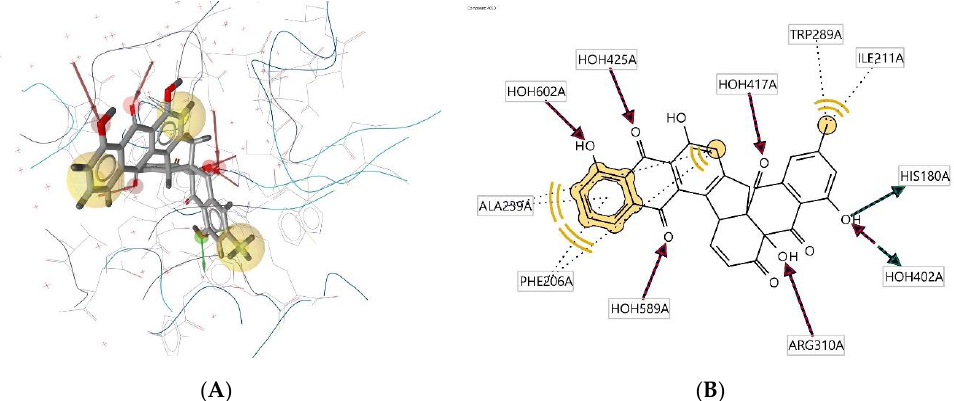
Figure 6. Ligand 465D interacts with the macromolecule. ( A ) 3D view of pharmacophore at macro- molecule binding site. ( B ) 2D view of the pharmacophore. Pharmacophore features: hydrophobic interactions (H), yellow; hydrogen bond acceptor (HBA), red; hydrogen bond donor (HBD), green. Ligand 302D interacts with the macromolecule, as shown in Figure 7A,B. It shows hydrophobic interactions with amino acids Thr266A, Trp82A, Thr134A, Phe206A, Trp289A, and Ile211A. This pharmacophore also has a hydrogen bond acceptor (HBA) feature to nearby water molecules and amino acid residues Trp82A, Ser79A, Arg215A, and Arg310A. Looking at the hydrogen bond donor (HBD) feature, the ligand interacts with Gln77A. Based on the interactions, this structure provides a pharmacophore with three features: hydrophobic interactions (H), hydrogen bond acceptor (HBA), and hydro- gen bond donor (HBD).